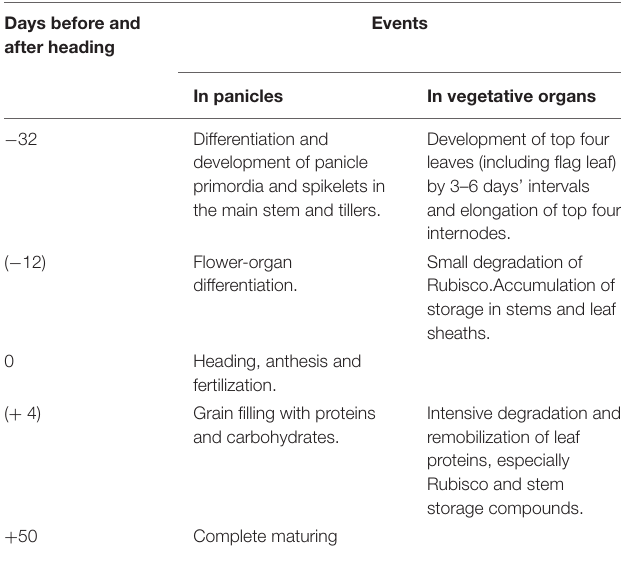
TABLE 3 | The two phases of the reproductive stage: 32 days before and 50 days after heading at day